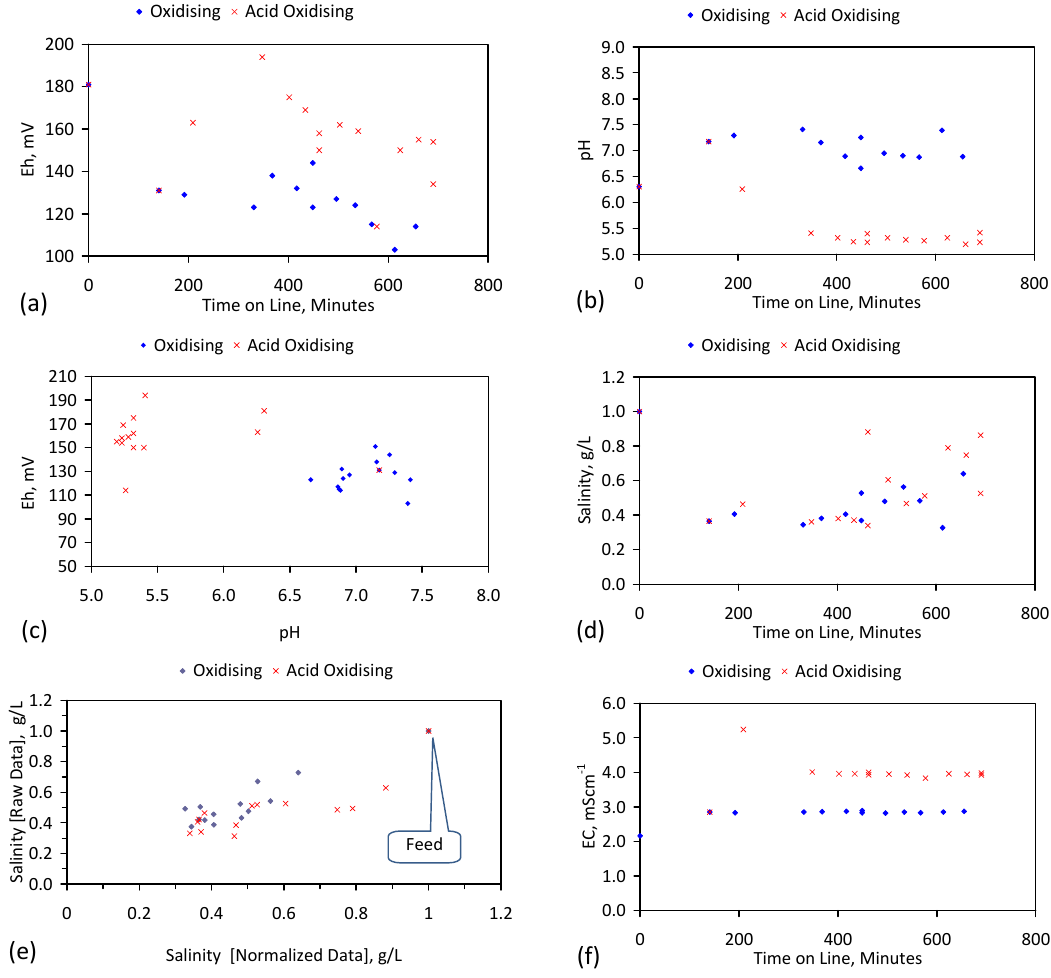
Figure C33. ZVM TPA example Trial E146. 13th Reuse; Operating Temperature: 11–19 °C; Oxidising Environment: Water volume in the reactor = 0.24 m 3 ; ZVM TPA from Trial E145 in a cartridge = 0.4 kg; Air flow = 120 L·h − 1 . Acid Oxidising Environment: Water volume in the reactor = 5.4 L; ZVM TPA from Trial E144 in a cartridge = 0.4 L; Gas flow (80% N 2 + 20% CO 2 ) = 3.3 L·h − 1 . ( a ) Eh vs. time; ( b ) pH vs. time; ( c ) pH vs. Eh; ( d ) Salinity vs. time; ( e ) Salinity calculated from normalised data vs. salinity calculated from raw data; ( f ) EC vs. time.